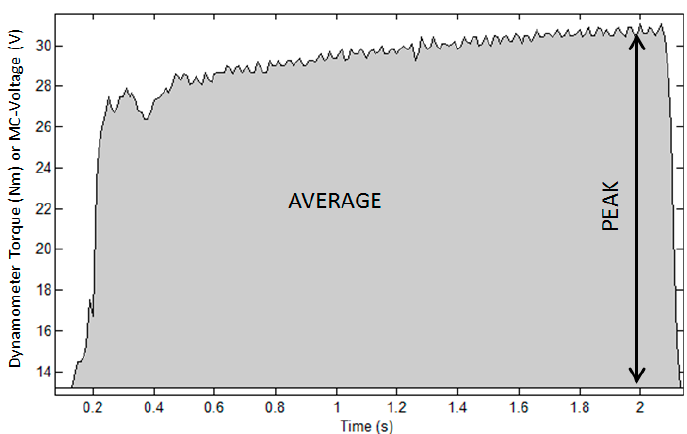
Figure 4 . Schematic representation of a single FES-muscle contraction for derivation of dynamometer peak torque and average torque.